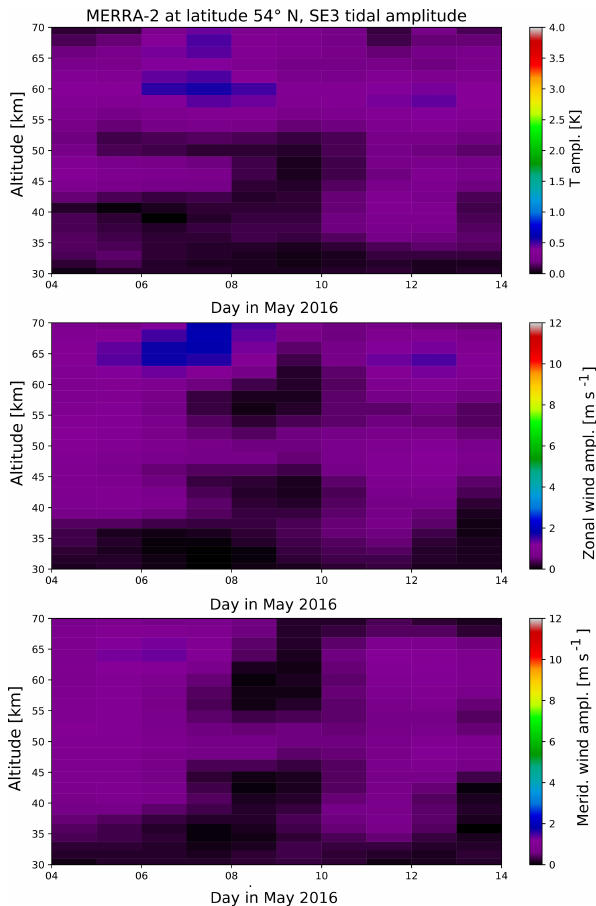
Figure A11. SE2 amplitude in temperature, zonal and meridional wind from global MERRA-2 fields at the latitude of 54 ◦ N.